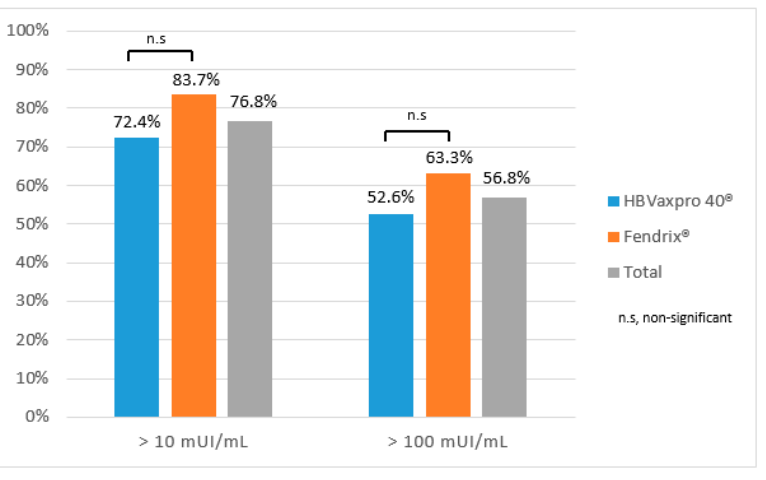
Figure 3. HBV vaccine response at two months. n.s, non-significant. Table 2. Comparison of patient characteristics between responders and nonresponders to HBV vac- cination by univariate analysis.